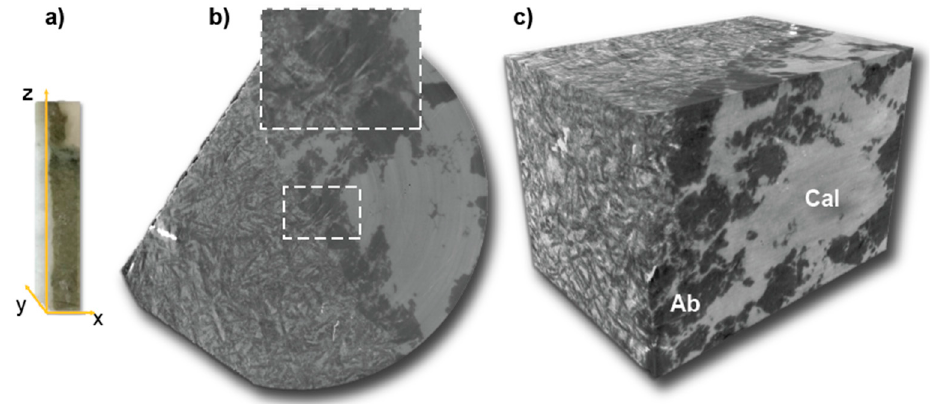
Figure 7. Sample 3 (S3). ( a ) Sample cut for tomographic scanning; ( b ) example of one single slice